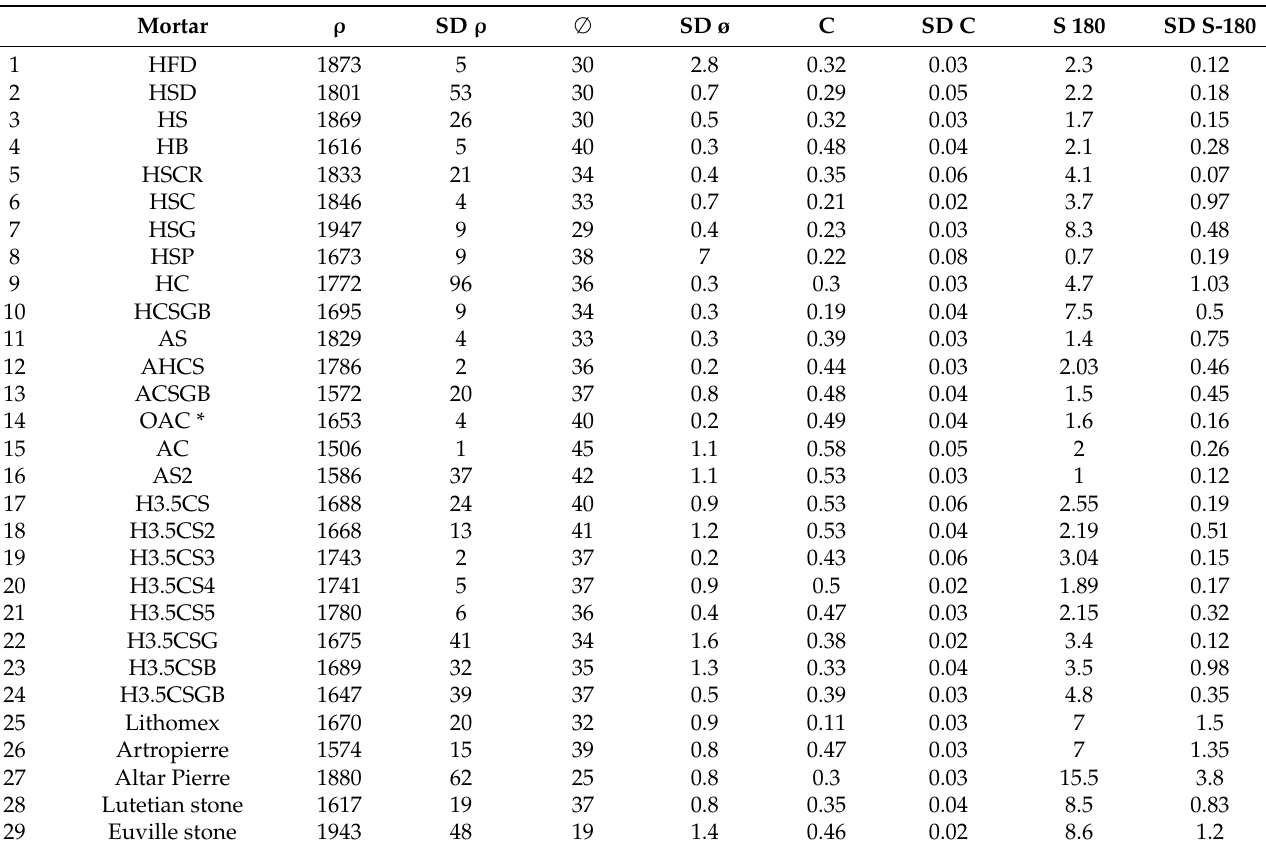
Table 6. Physical and mechanical properties of selected mortars for Lutetian stone. ρ b : density (kg/m 3 ), ∅ : open porosity (%), C: capillarity coefficient (kg/m 2 s 1 ⁄ 2 ), CS 180: compression strength at 180 days (MPa), SD standard